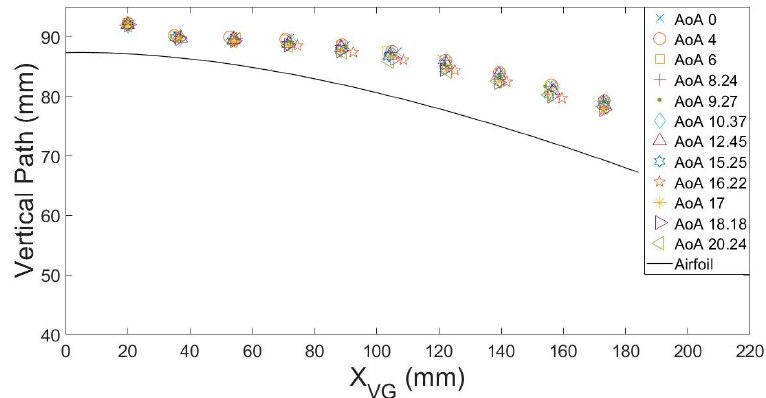
Figure 7. Comparison of vertical peak vorticity paths for different angles of attack (AoAs).